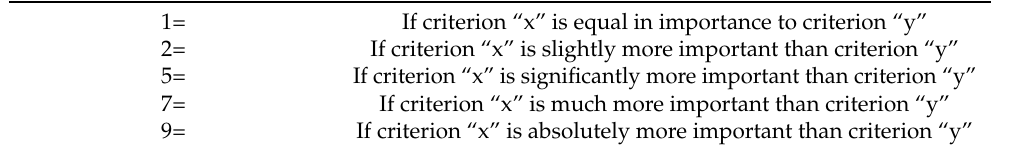
Table 3. Importance rating for the construction of the